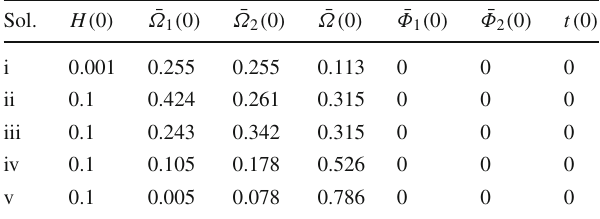
Table 2 Five initial data sets for the simulation of the truncated system (B.22) and time-averaged system (B.23). All the conditions are chosen in order to fulfill the inequality ¯ Ω 1 + ¯ Ω 2 + ¯ Ω ≤ 1